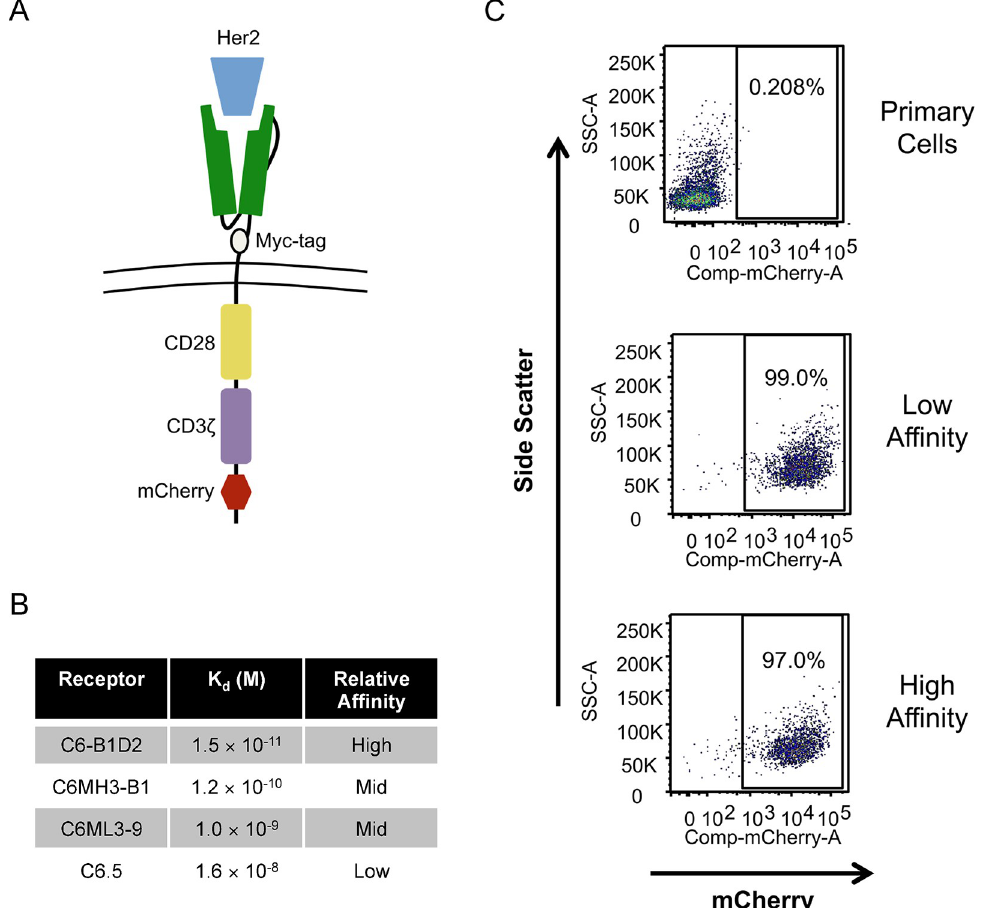
Fig 1. Chimeric antigen receptors used for tunable T cell signaling. (A) The design of CARs including CD3 z and CD28 signaling domains. ( B ) CAR single chain variable fragments with their corresponding dissociation constants for the Her2 ligand. We refer to these CARs by their relative ligand affinity. ( C ) Enrichment of primary CD4+ T cells based on mCherry expression following CAR transduction.